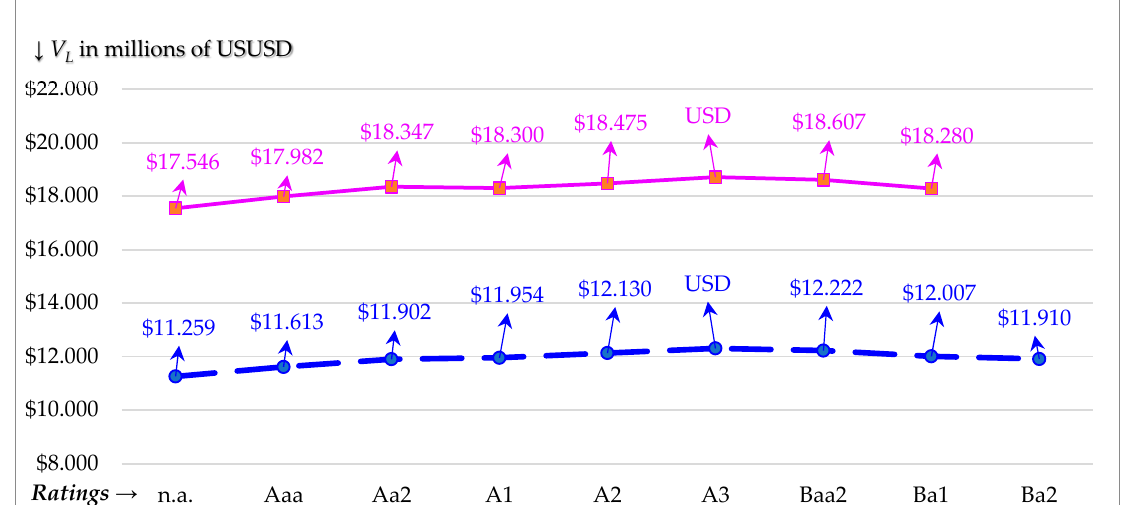
Figure 3. Firm Value ( V L ) values are plotted along the vertical axis against Moody’s credit ratings along the horizontal axis. The nonprofit trajectory is the solid line and the pass-through trajectory is the dashed line. We use credit spreads for 2019, TCJA low ( L ) tax rates, and 3.12% growth where the growth ( RE ) constraint sets in after Ba1 for nonprofits (NPs) and after Ba2 for pass-throughs (PTs). The optimal credit rating ( OCR ) is A3.